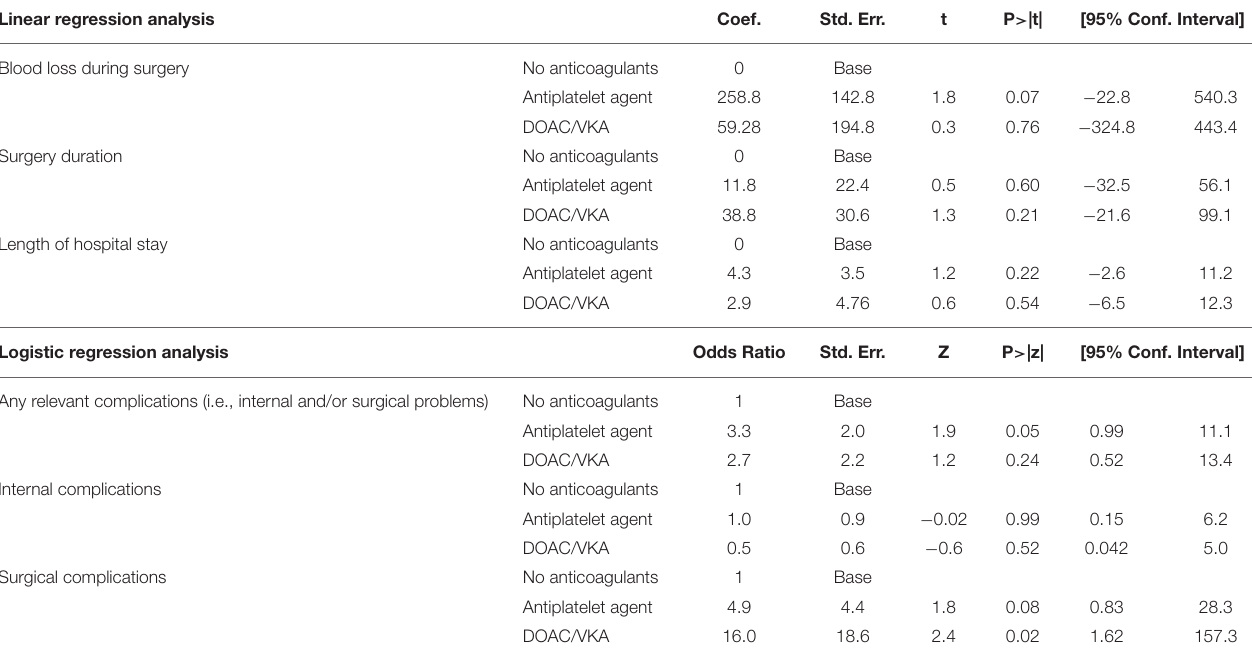
TABLE 4 | Multivariable analysis of complications including confounders (i.e., age at surgery, sex, BMI, ASA status, smoker, hypertension, diabetes, coronary artery disease, atrial fibrillation, pacemaker, creatinine pre-operative, preoperative Hb). Linear regression